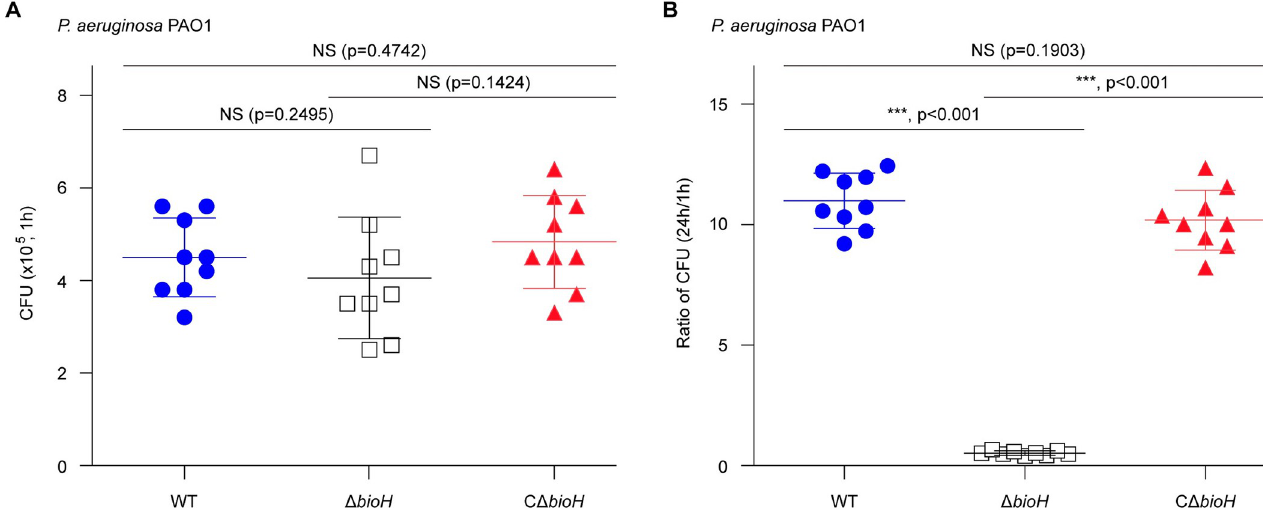
Fig 5. The requirement of BioH (PA0502) for survival of P . aeruginosa in mBMDM macrophage. A. Measurement of bacterial cell counts prior to challenge with P . aeruginosa . B. The removal of PA0502 dramatically impair the persistence of P . aeruginosa within macrophages. Data are shown as means ± SD, and were assayed by two-tailed analysis of variance. Designation: NS, not significant; WT, P . aeruginosa PAO1; Δ bioH , the Δ PA0502 mutant of P . aeruginosa PAO1; C Δ bioH , the complemented strain of the P . aeruginosa Δ PA0502 mutant with a plasmid pAK1900-borne PA0502.